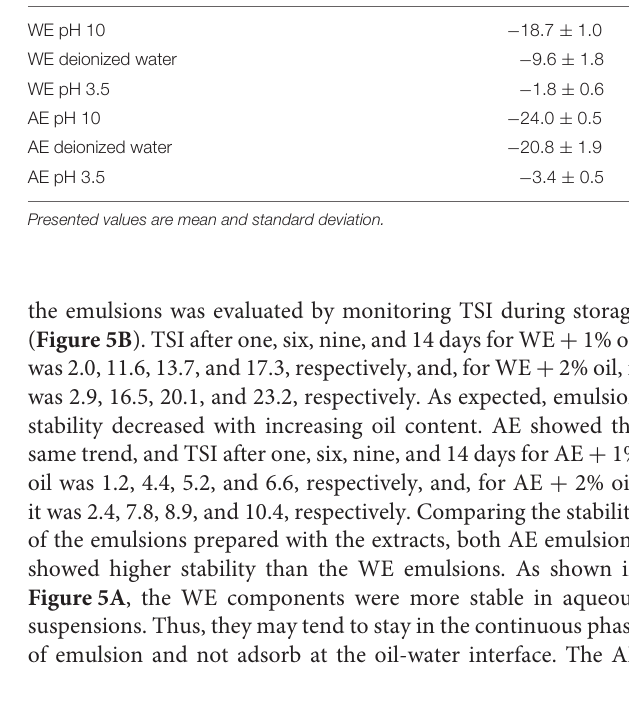
TABLE 1 | Zeta potential of water extraction (WE) and alkaline extraction (AE) suspensions measured instantly after preparation.